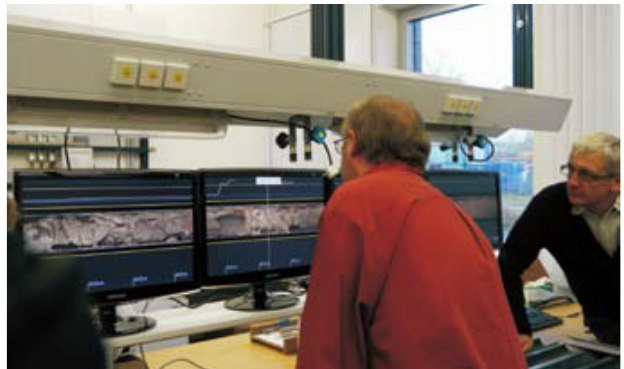
Figure 3. Corelyzer station at the IODP Exp. 313 New Jersey Shallow Shelf onshore science party at MARUM (University of Bremen). This station was fed continuously with scanned images and MSCL data of new core sections as they were added to the ExpeditionDIS. In conjunction with Correlator, this station was used for correlation between sites using lithological features and/or logging data. (Photo by H. Ando, Ibaraki